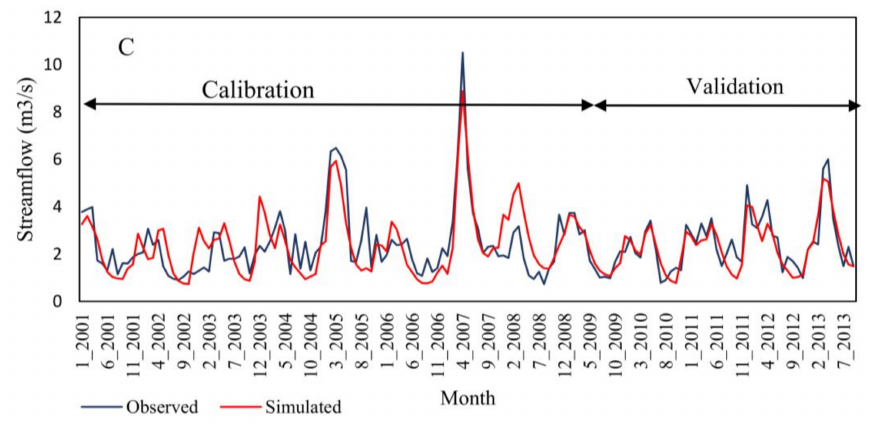
Figure 6. Hydrographs of observed and simulated monthly flow at Shirgah ( A ); Kerikkola ( B ) and